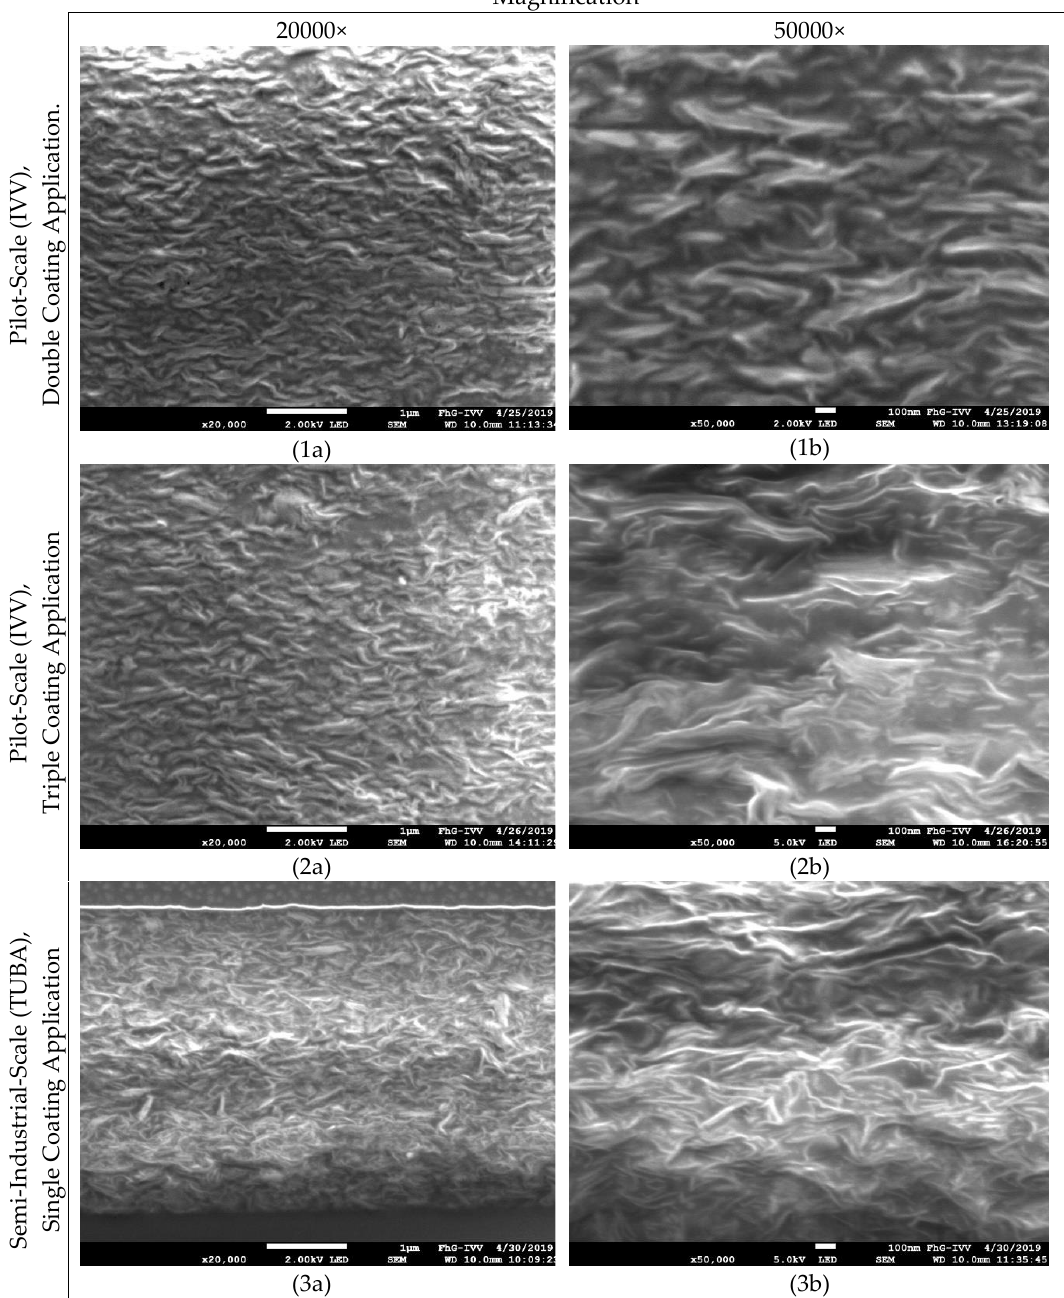
Figure 3. Scanning electron microscopy (SEM) images, at different magnifications, ( a ) at a magnification of 20,000 and ( b ) at a magnification of 50,000, of whey protein-isolate (WPI)-based nanocomposite coatings produced at both (1,2) pilot- and (3) semi-industrial-scale. This indicates that despite the differences in the preparation method of the aqueous coating formulations at the different production scales, for the most part viscosity differences due to the sequence of the processing steps (since the viscosity of the WPI-based dispersions increases after heat- treatment due to denaturation-associated unfolding of proteins) as well as differences regarding the applied shear-rates (the ultimate degree of particle orientation and the intercalation/exfoliation state of the particles) are mainly affected by the solid state pre-dispersion of the nanoplatelets by means of high-energy ball-milling during the production of the ready-to-use formulation.